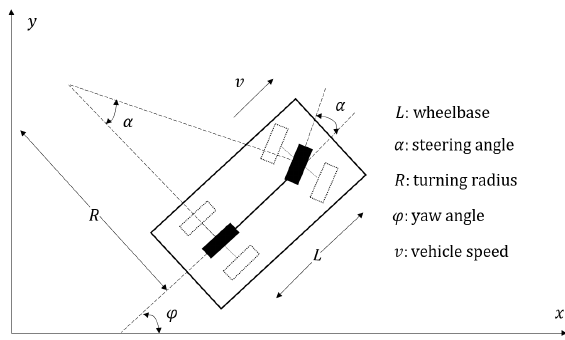
Figure 2. The kinematic model with front-wheel